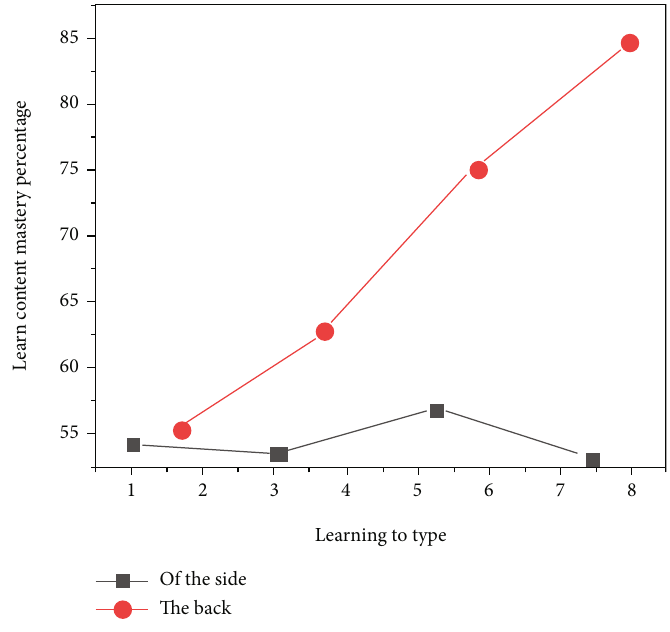
Figure 11: Experimental study on the way of ICAP participation.